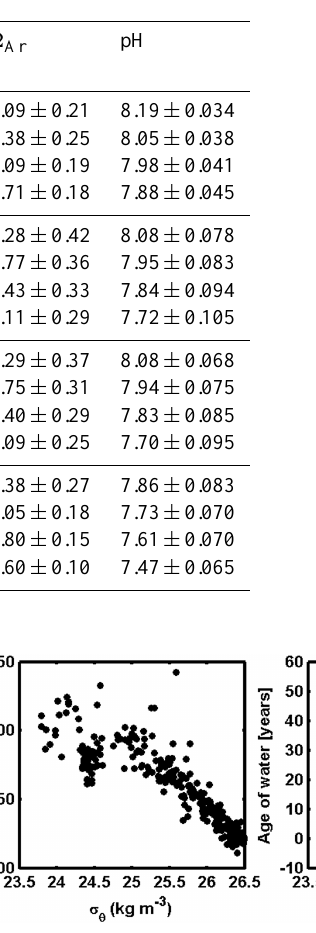
− age Figure 3. f CO 2012 calculated from hydrographic data (left) 2,eq and the calculated age– σ θ relationship (right) is shown. Good agreement ( R 2 = 0.87) between the data (black circles) and the fit (age = 8.852 (σ θ − 25 . 2 ) 2 + 23 . 132 ( σ θ − 25 . 2 ) ; red line) is observed (right). Age of surface waters ( σ θ < 25 . 2kgm − 3 ) was assumed to be